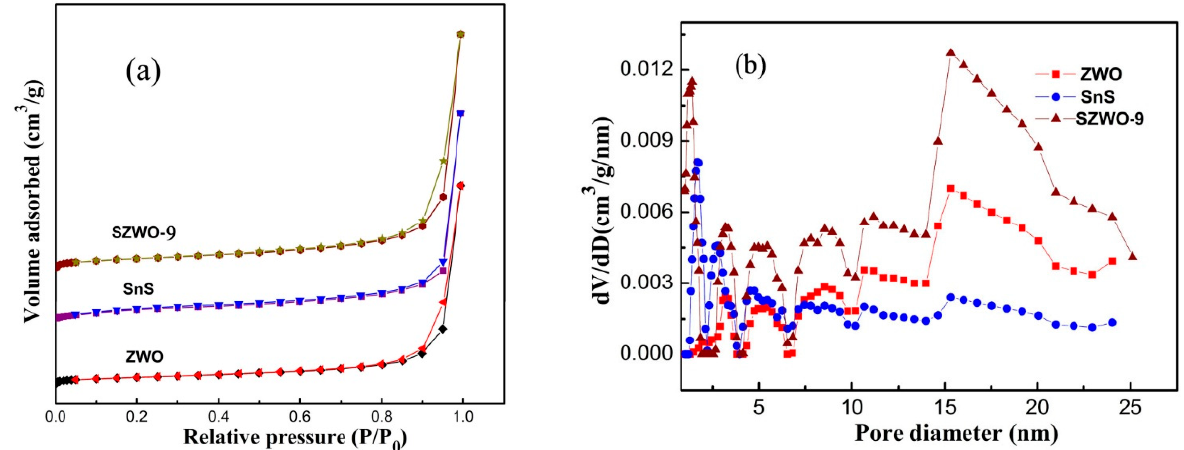
Figure 5. ( a ) The Nitrogen adsorption–desorption isotherms and ( b ) the corresponding pore size and distribution curves of ZWO, SZWO-9 and SnS samples.